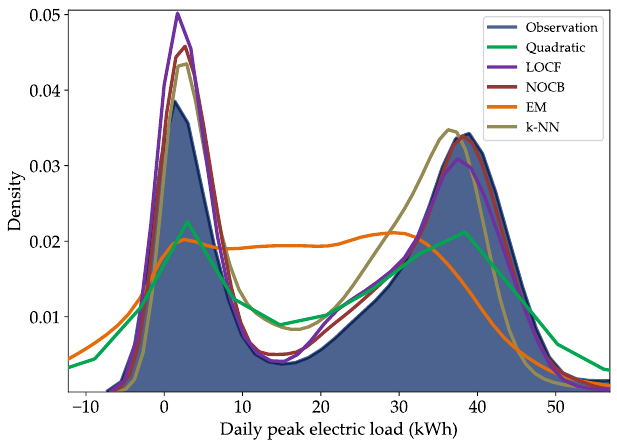
Figure 9. Density estimation of the observations and imputed